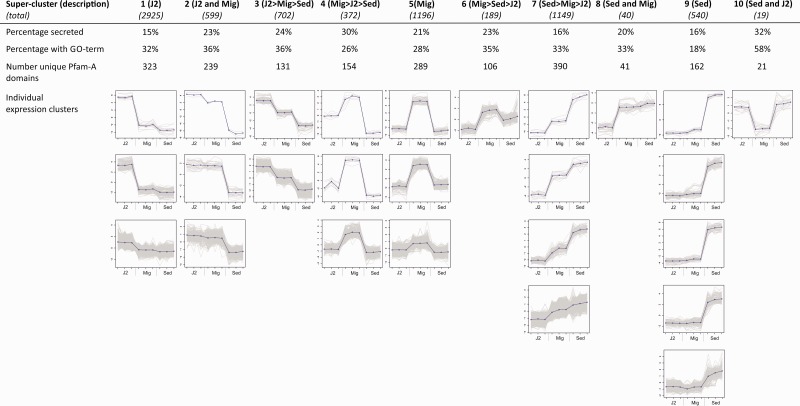
Transcripts clustered by differential expression. For all expression clusters, mean centred log fold change of expression is plotted for each of the three biological replicates for each life stage in the following order: J2, mixed J3/J4/female migratory (Mig), and sedentary female (Sed). A total of 7,731 differentially expressed transcripts clustered into 26 clusters based on expression profile. Clusters are manually grouped into ten super clusters with summarized expression.